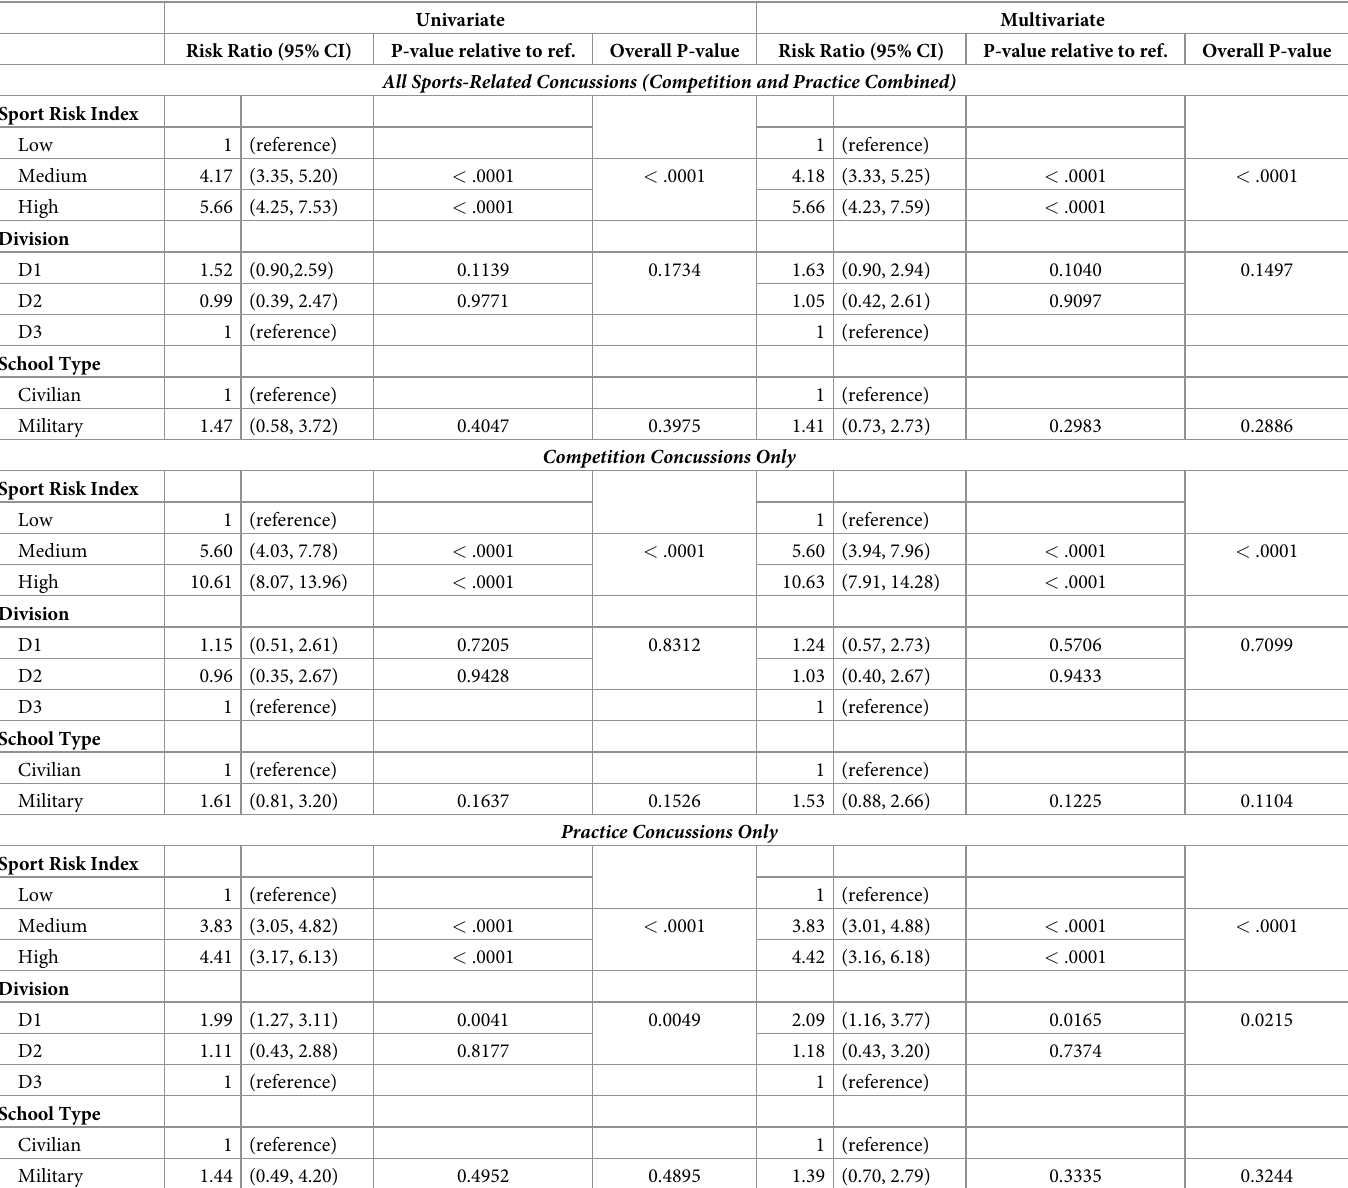
Table 3. School-level risk factors for sports-related concussion, CARE CSC, 2014/15 to 2018/19 academic years. Univariate Multivariate Risk Ratio (95% CI) P-value relative to